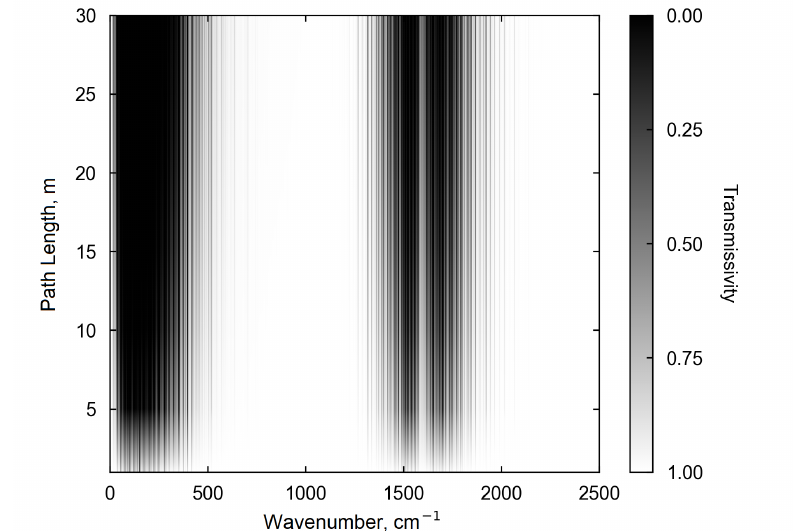
Figure 1. Spectral transmission of longwave radiation as a function of path length. Model results from MODTRAN 4.1 [15] for radiance emitted from a planar surface at 300 K through a standard atmosphere with absolute humidity of 8 gm − 3 . Sampled at heights of 1, 5, 10, 15, 20, 25, and 30